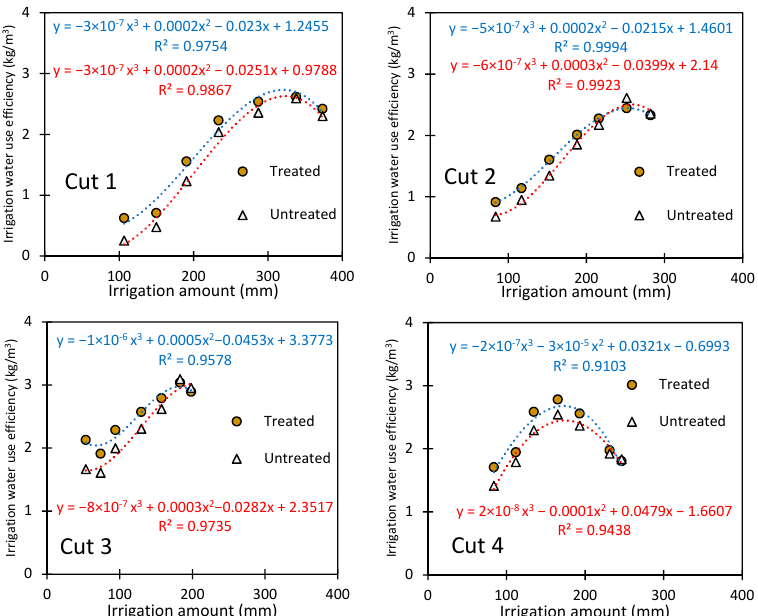
Figure 6. Irrigation water use efficiency of alfalfa as function of irrigation amount at each cut during the 2014 growing season.